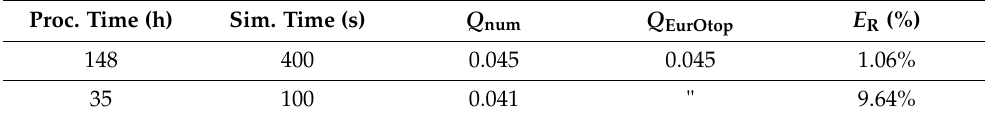
Table 9. Q for simulation times of 100 and 400 s.